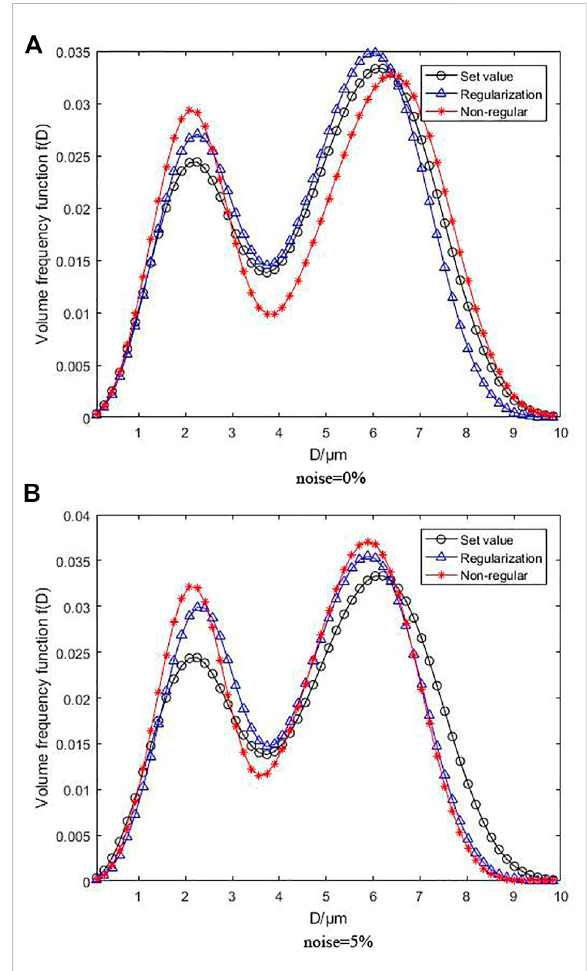
FIGURE 4 Inversion results following bimodal R-R distribution without noise and with 5%